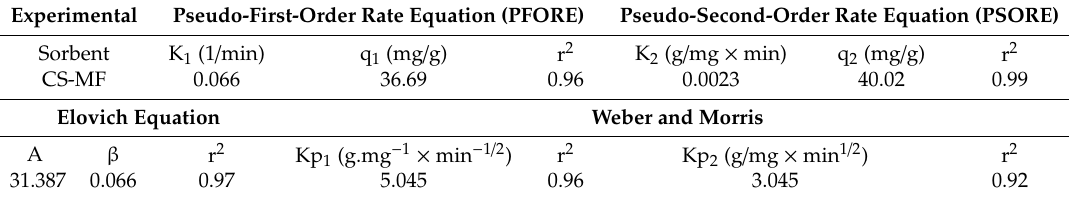
Table 4. Kinetic parameters of CS-MF.